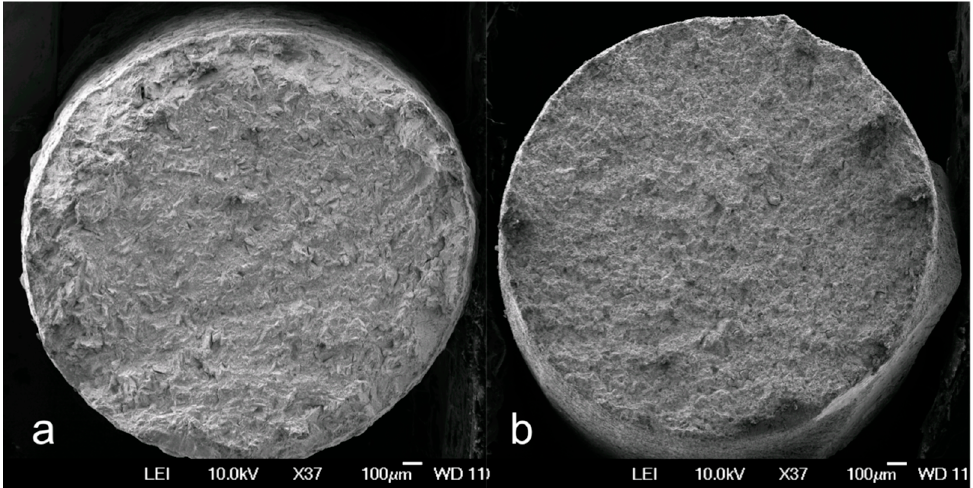
Figure 2. Representative SEM image at ×37 showing ( a ) fracture surface of LS CoCr dumbbell and ( b )